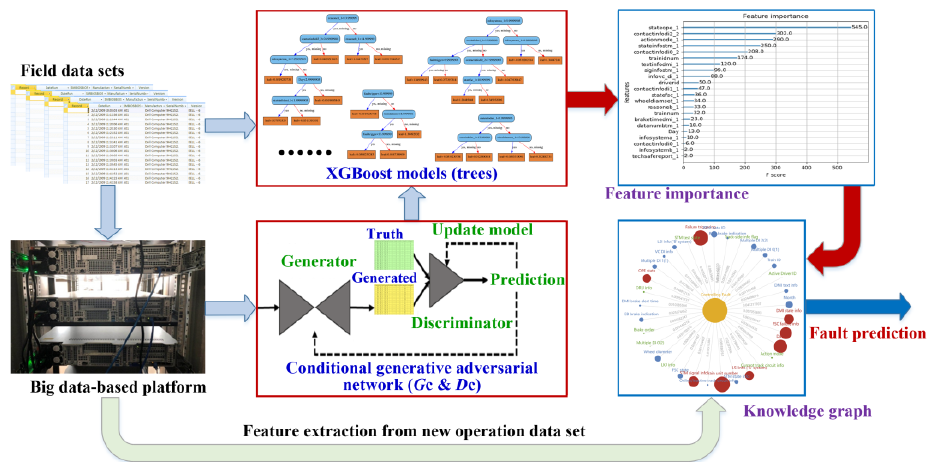
Figure 5. Procedures of fault prediction model training by CGAN and XGBoost.